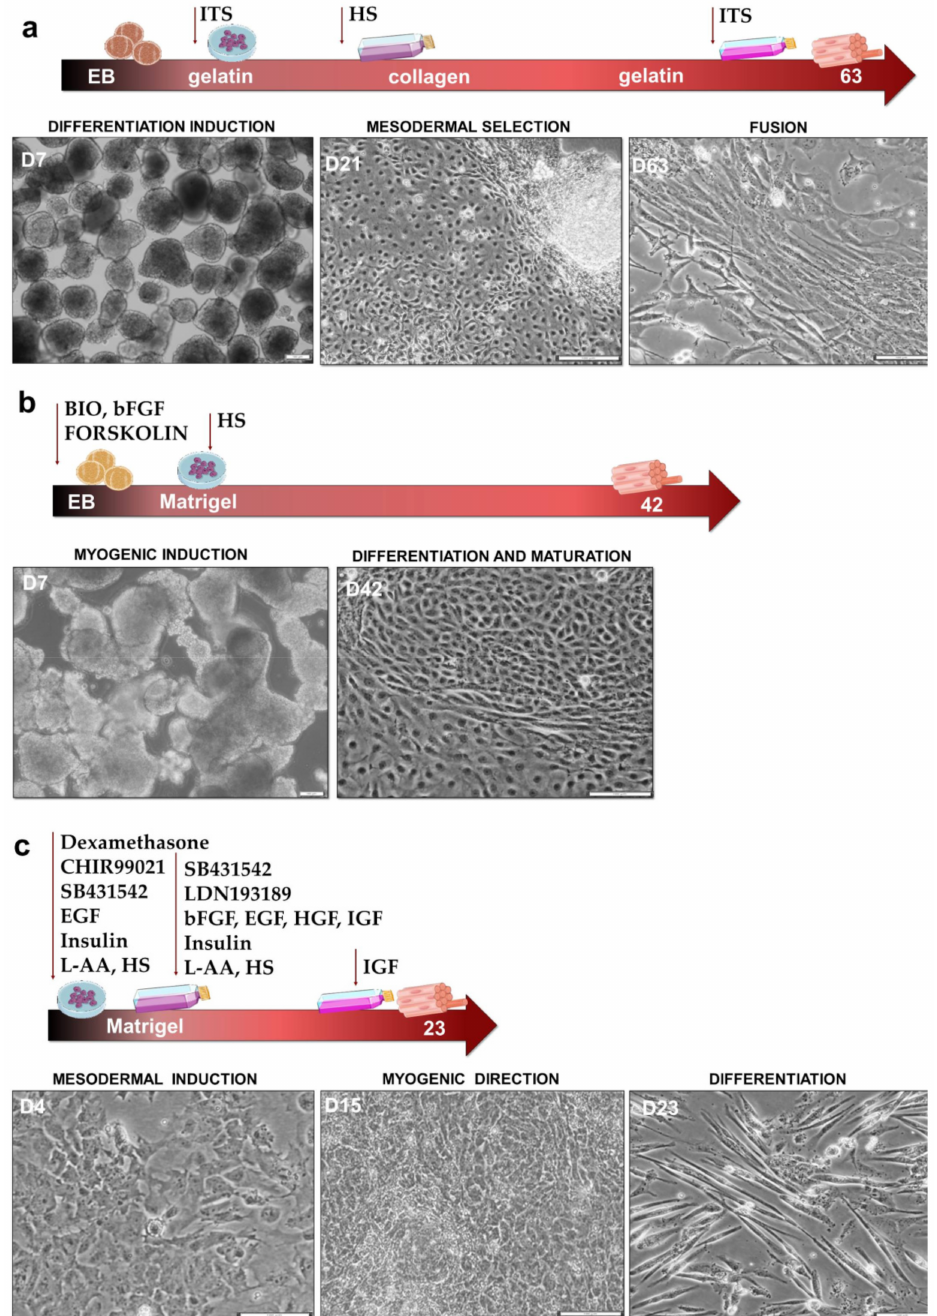
Figure 1. Schematic representation of the key steps, signaling modulators, and duration of particular protocols of differentiation into skeletal muscle with corresponding cell morphology changes. Scale bar represents 50 µ m. ( a ) Protocol I; ( b ) Protocol II; ( c ) Protocol